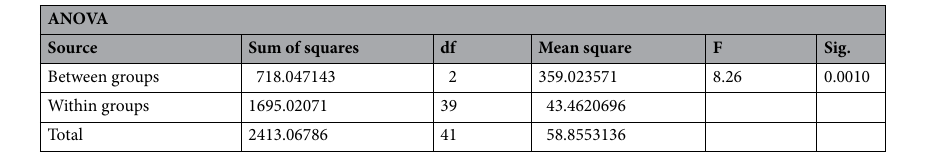
Table 3. Analysis of variance of noise levels for morning, midday and afternoon. Df degree of freedom, Sig. level of